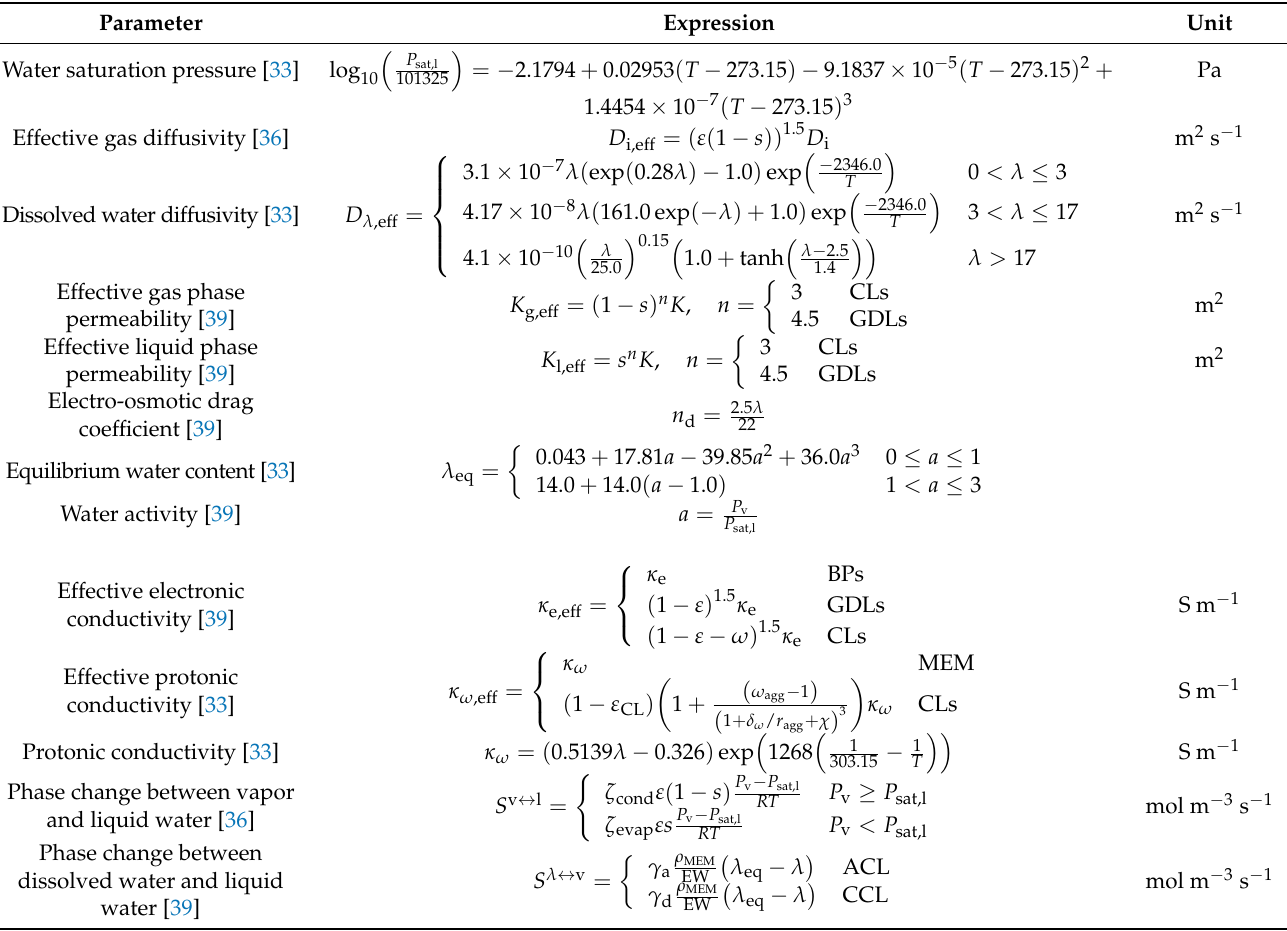
Table 2. Transport properties.